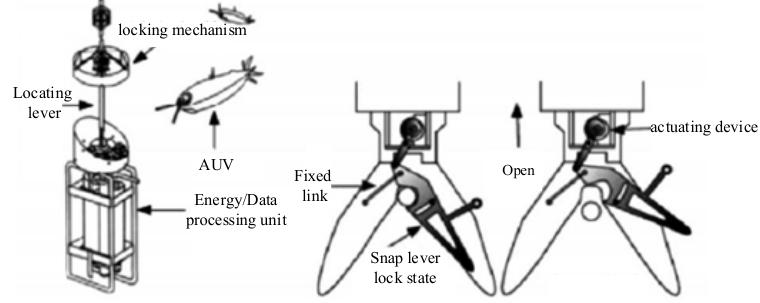
Figure 4. Underwater capture docking device .